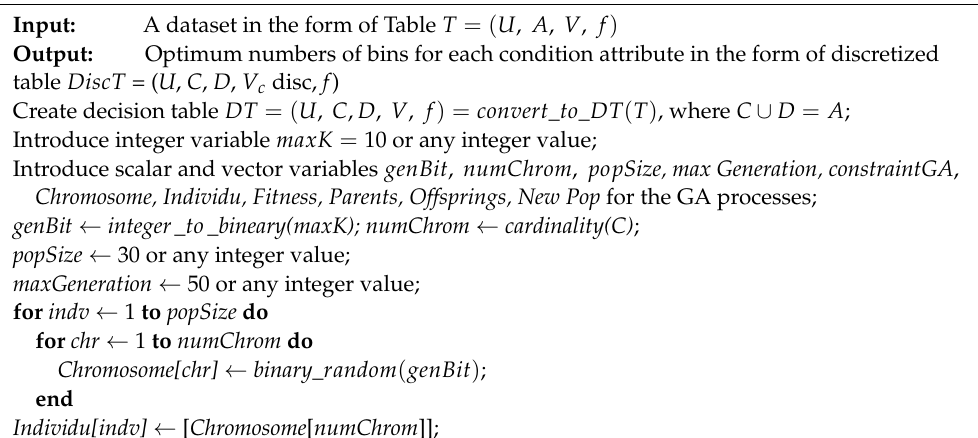
Algorithm 1. Pseudo-code of proposed